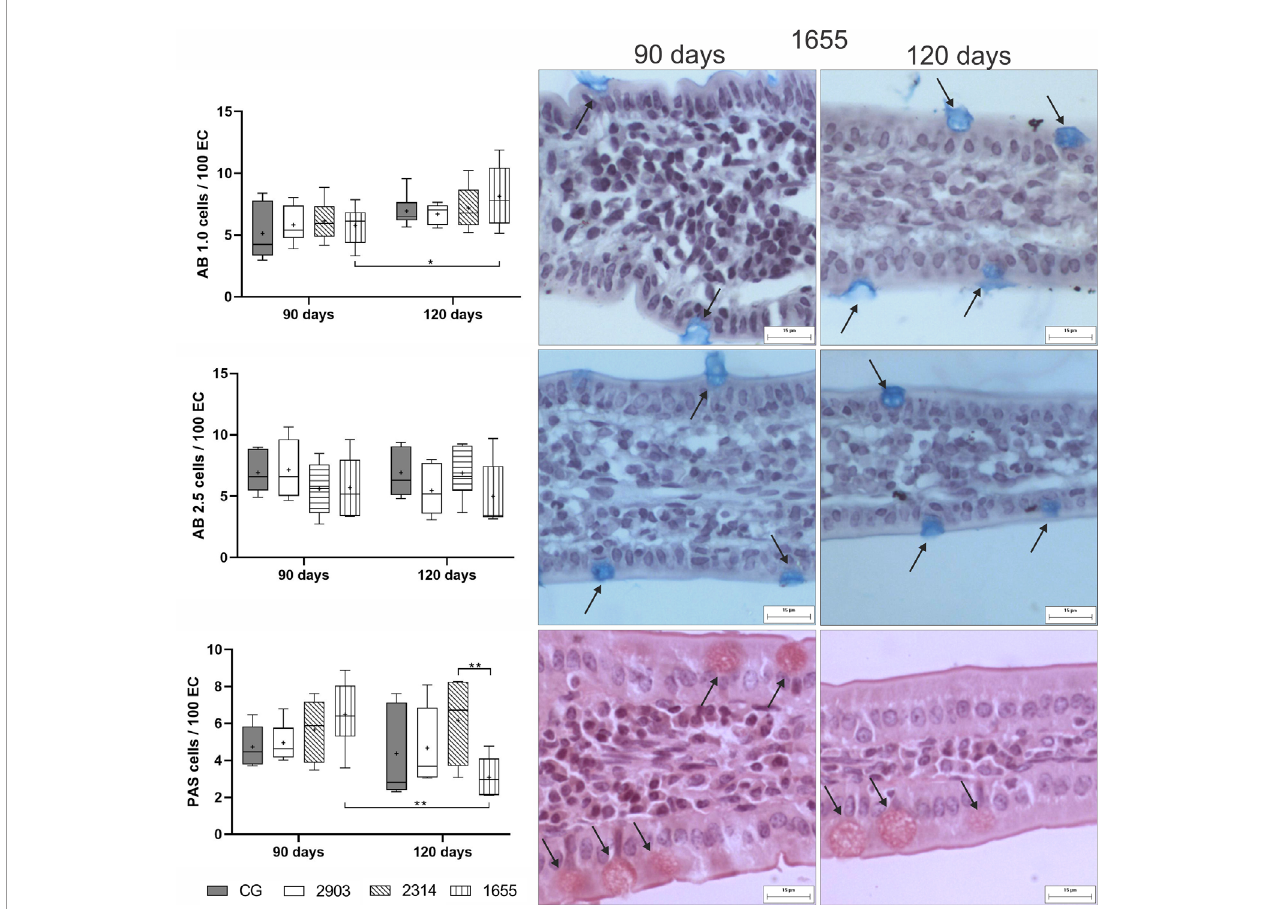
FIGURE 7 | Ratio of globlet cells/100 of epithelial cells (EC) stained using the histochemical techniques of Alcian Blue (AB) pH 1.0, AB pH 2.5, and periodic acid- Schiff (PAS). Data is represented in box plots (median with 25 to 75 percentile), whiskers (2.5 to 97.5 percentile), and mean (+) ( n = 6). * p < 0.05; ** p < 0.01. Representative photomicrograph of the group 1655 at 90- and 120-days post infection showing goblet cells (black arrows) in each technique (AB pH 1.0 and 2.5 and PAS staining, 40× magni fi cation, scale bar = 15 μm, Olympus BX50). CG, control group. 2903: group infected with MHOM/BR/1975/M2903. 2314: group infected with MHOM/BR/2003/2314. 1655: group infected with